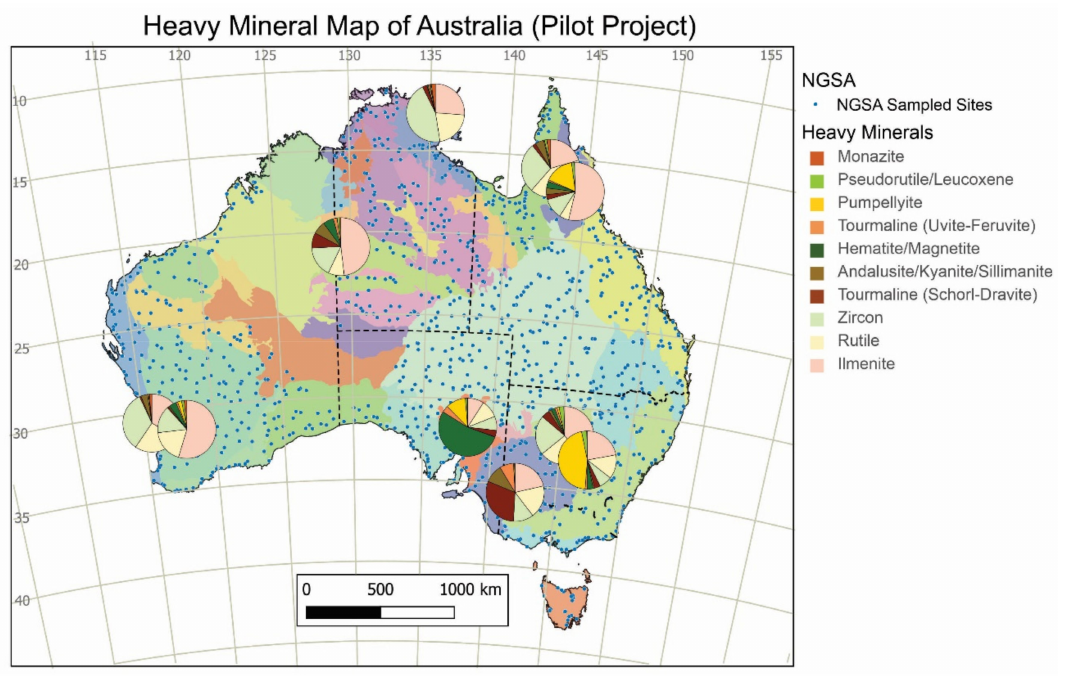
Figure 3. Distribution map of 10 selected heavy minerals in the heavy mineral (H) fractions of the 10 NGSA samples (pie charts), overlain on Australia’s geological regions (variable colors; [34]). Map projection: Albers equal